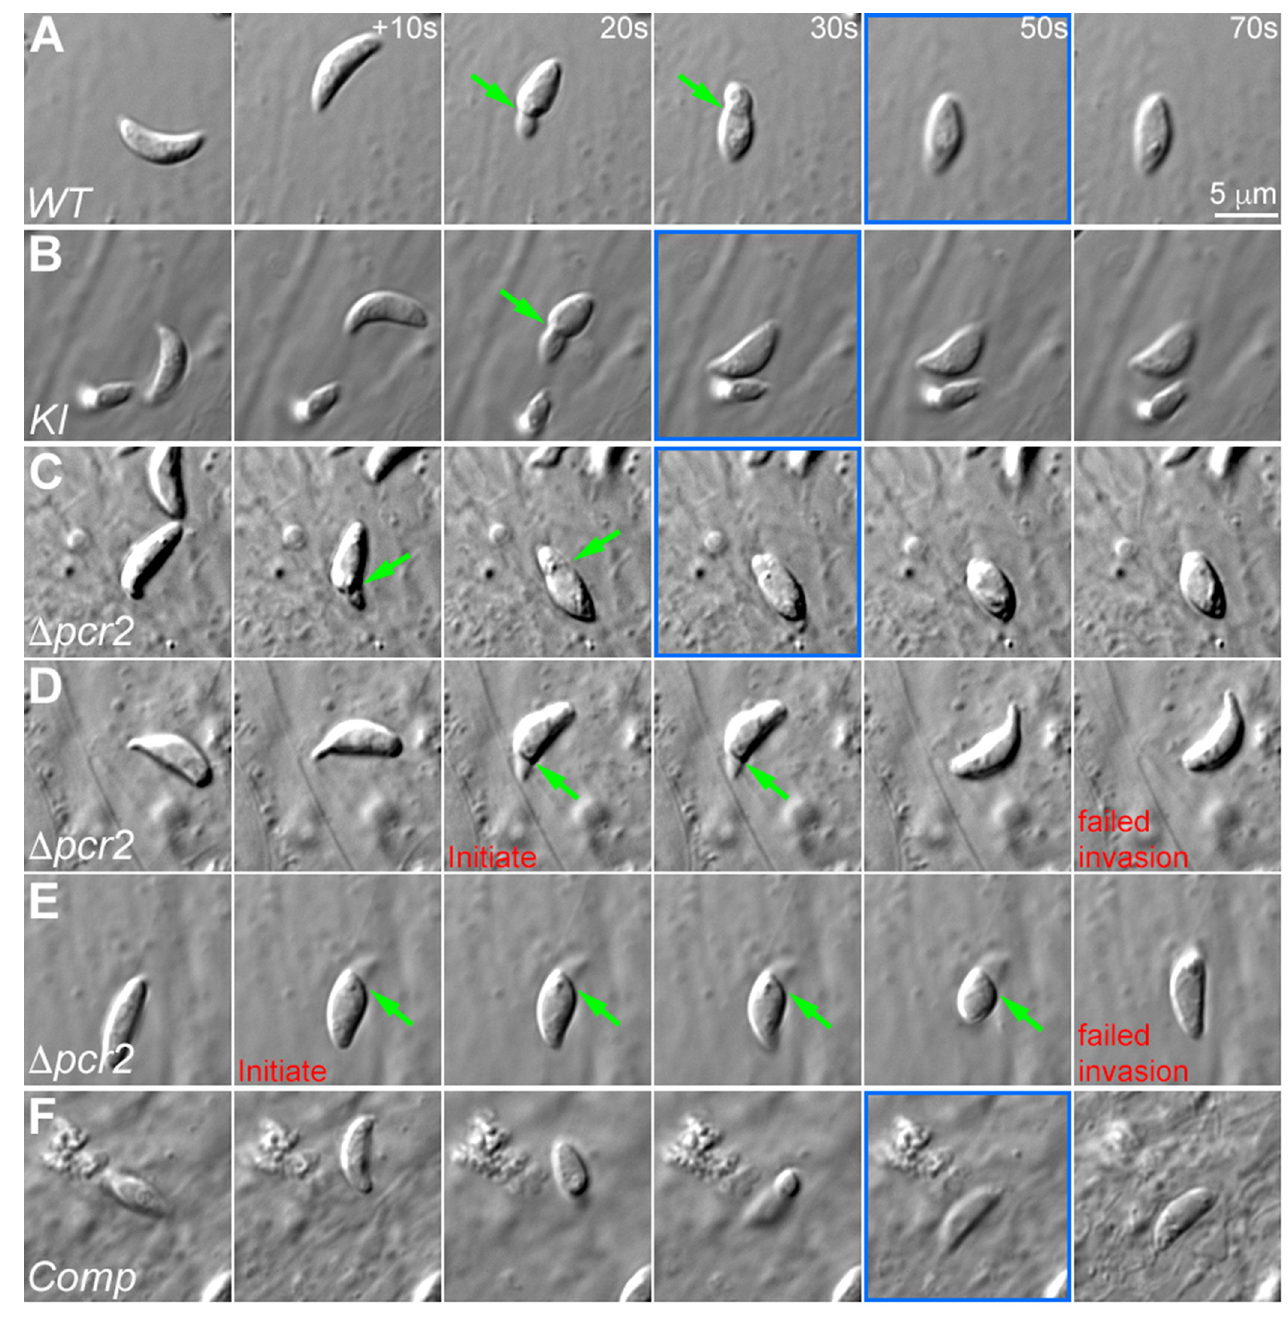
Fig 9. The Δ pcr2 parasite moves fitfully during invasion. Images selected from time-lapse recording of RH Δ hx Δ ku80 ( WT , A ), mEmeraldFP-Pcr2 knock-in ( KI , B ), knockout ( Δ pcr2 , C-E ), and complemented ( Comp , F ) parasites in the process of invasion or attempted invasion. D and E show two examples of abortive invasion by the Δ pcr2 parasite. The frames where the invasion has completed are marked in blue. Green arrows: constrictions formed during invasion. Also see S8